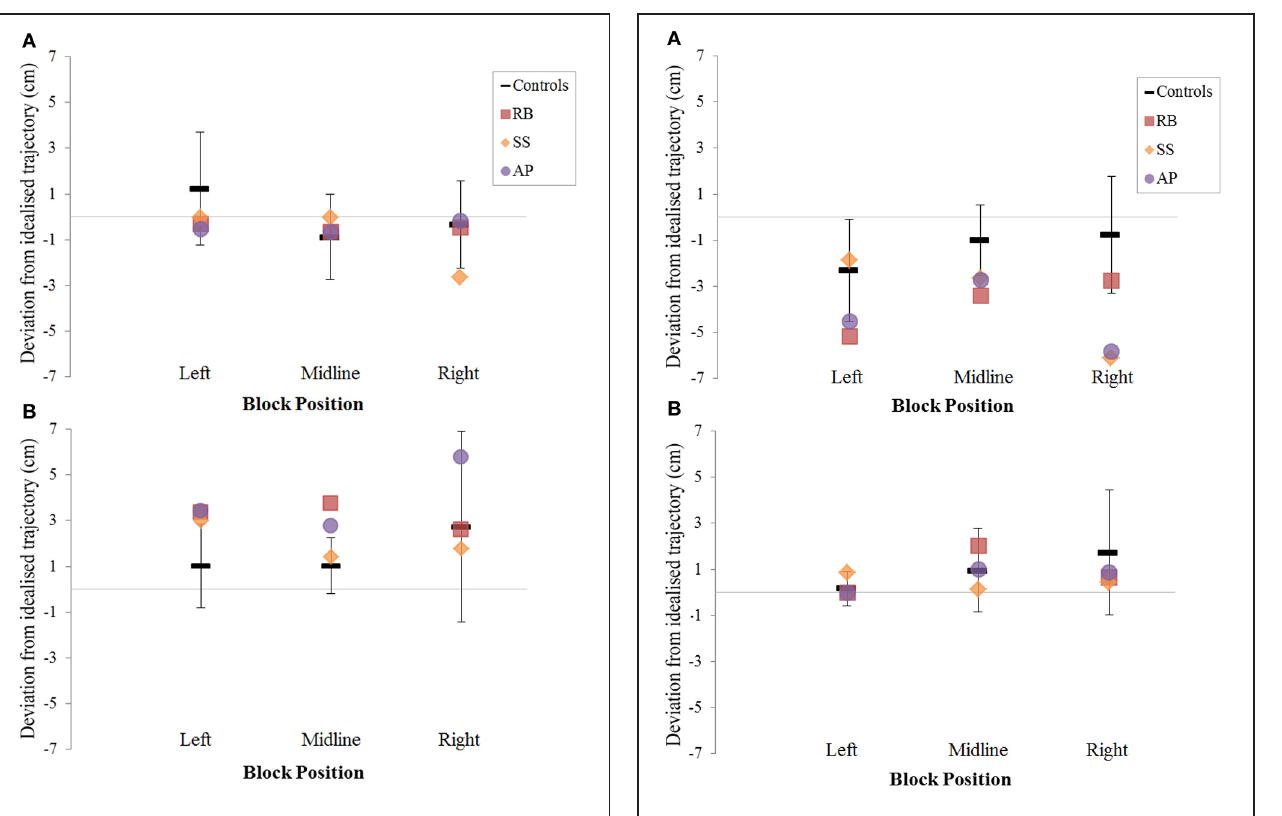
FIGURE 8 | The (A): leftward and (B): rightward reach path deviations in Experiment 2 for reaches made with the left